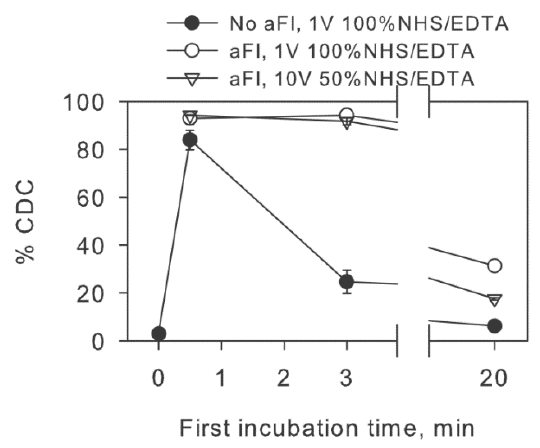
Figure 3. mAb A247 prolongs the lifetime of functional C3b. Z138 cells opsonized with 10 µg/mL OFA were subjected to the two-step treatment as in Figure 1, in the presence (open circles) or absence (filled circles) of mAb A247 specific for Factor I. The second step incubation was begun either by addition of an equal volume of 100% NHS supplemented with 20 mM EDTA (filled and open circles) or by addition of ten volumes of 50% NHS supplemented with 10 mM EDTA (open triangles).